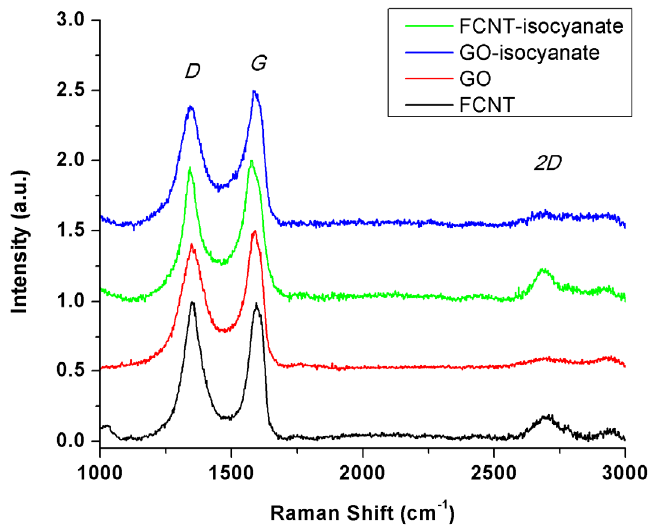
Figure 5. Raman spectra of pure GO and FCNT and isocyanate composite with GO and FCNT.